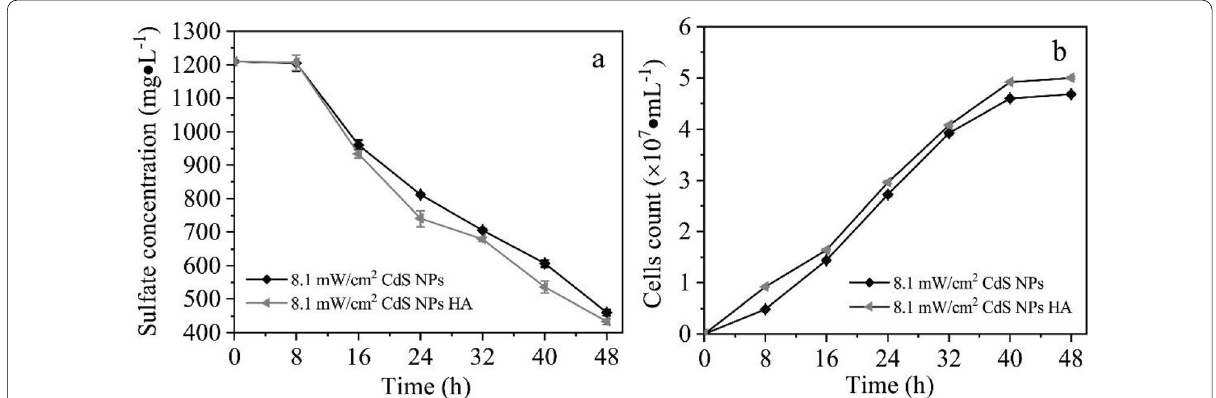
Fig. 13 Effects of HA on sulfate reduction and growth of C09. a Sulfate concentration; b